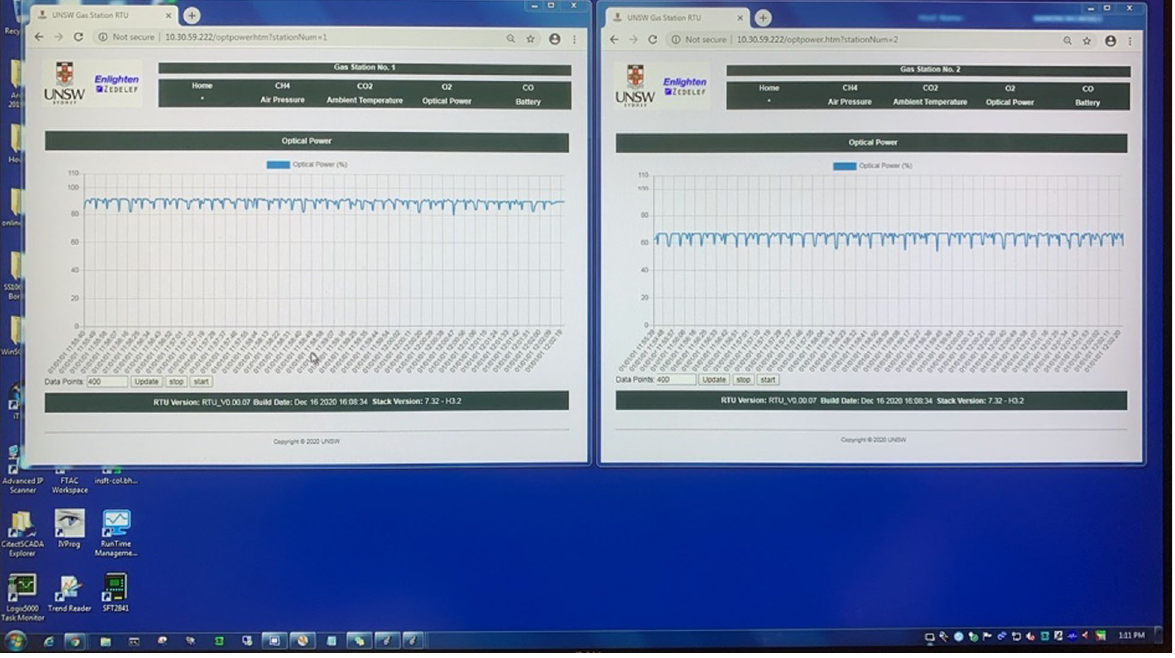
Fig. 7 Screen grab of the data reported by both gas monitoring stations during their first day of operation. As shown, the data (optical power delivered to both stations) covers a time scale of about 6